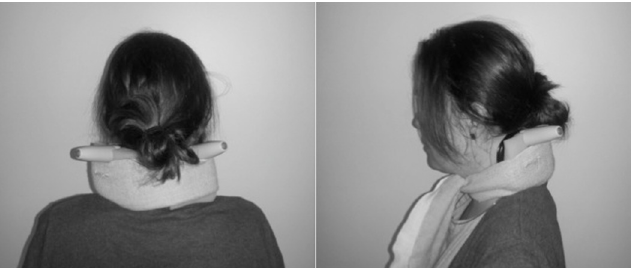
Fig 4. An image of the vibration apparatus. Bilateral vibration of the dorsal neck muscles was applied using two handheld vibrators embedded in foam blocks that were secured with a tensor bandage. The individual photographed has given written informed consent (as outlined in PLOS consent form) to publish this